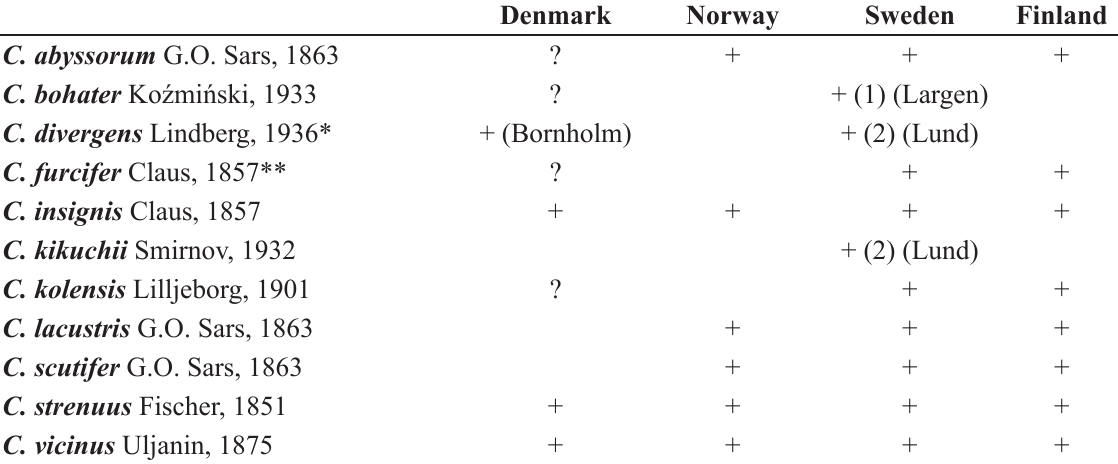
Table 1. Cyclops species of Fenno-scandinavia (Herbst 1951; Lindberg 1957; einsle 1968, 1996a; silfverberg 1999; Boxshall & Defaye 2013; this paper). + = species present; ? = expected in Denmark, as the species occurs in northern Germany and scandinavia; (1) = this paper; (2) = unpublished data of mH; * = Cyclops abyssorum divulsus Lindberg, 1956 is here considered as a junior synonym of Cyclops divergens Lindberg, 1936; ** = the records may refer to more than one